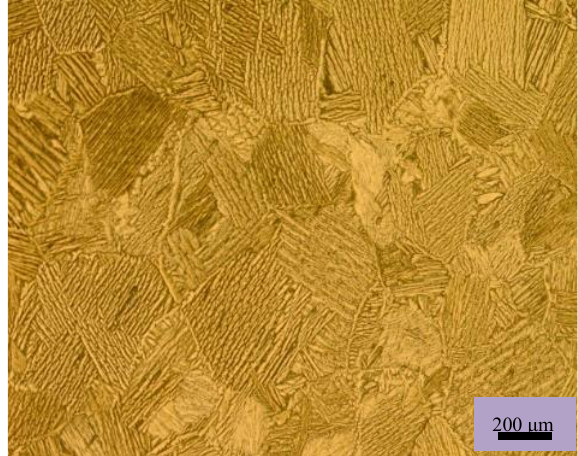
Fig. 2. Initial microstructure after primary and secondary hot rolling and heat